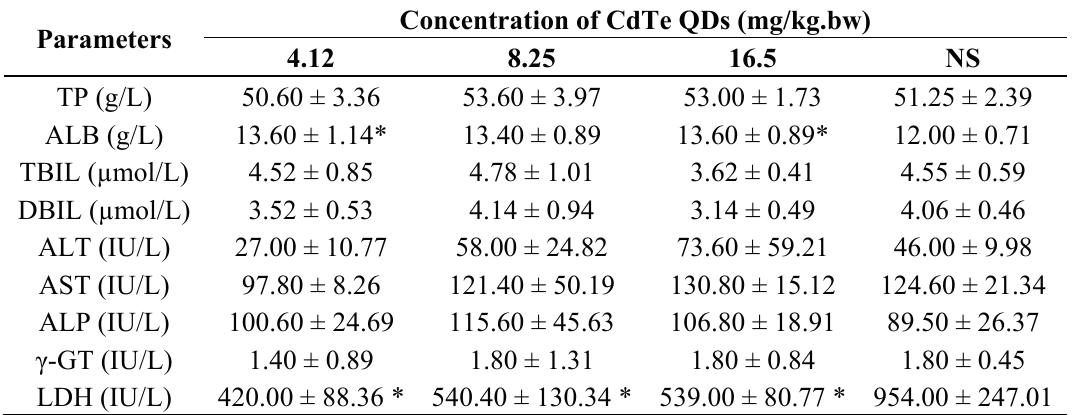
Table 3. Clinical chemistry of mice after 28 days intravenous treatment with CdTe QDs (mg/kg.bw).